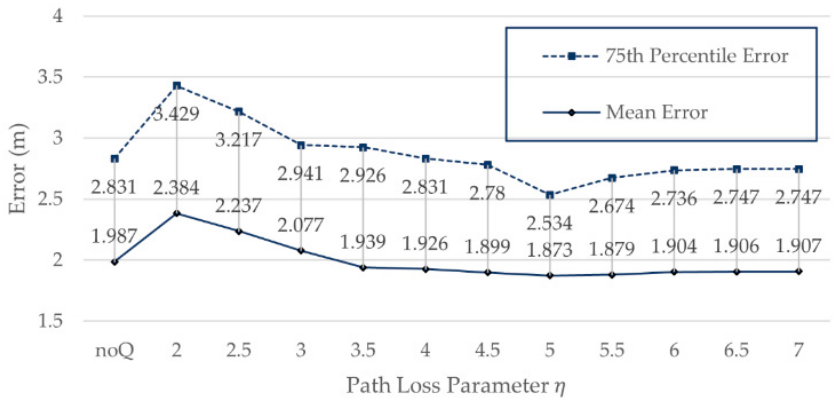
Figure 7. Positioning errors of different values of η on Zenodo.